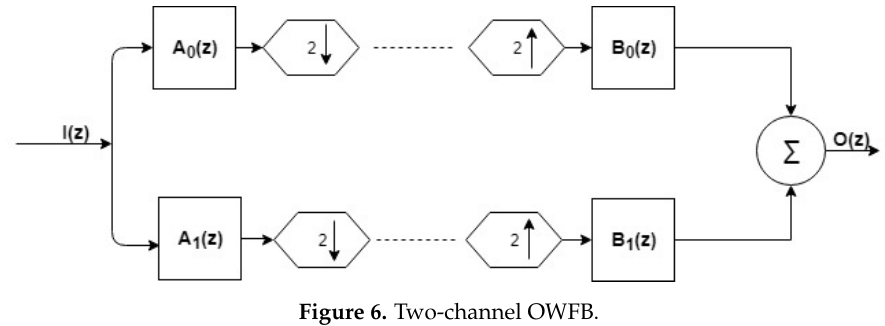
Figure 6. Two-channel